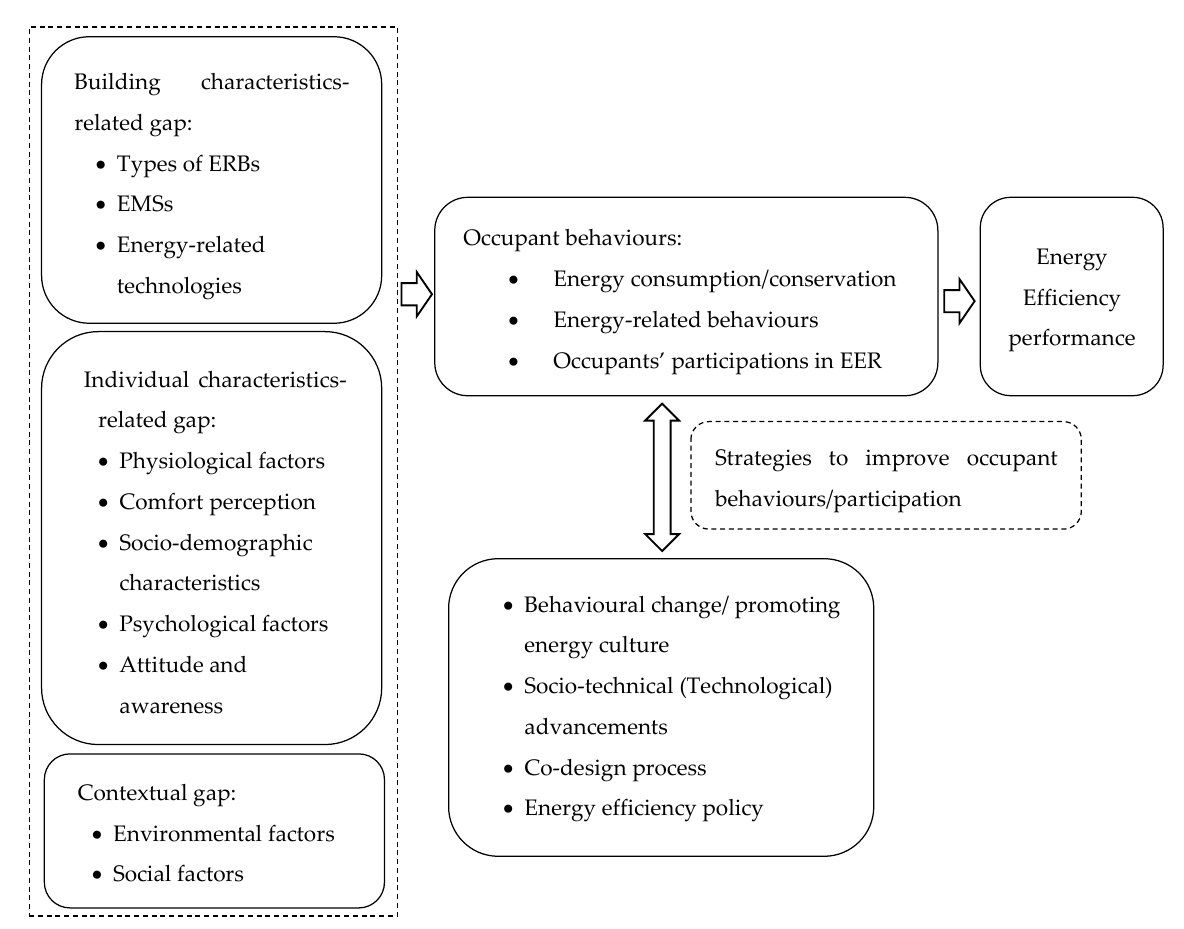
Figure 7. The theoretical framework of the Figure 7. The t heoretical framework of the study.